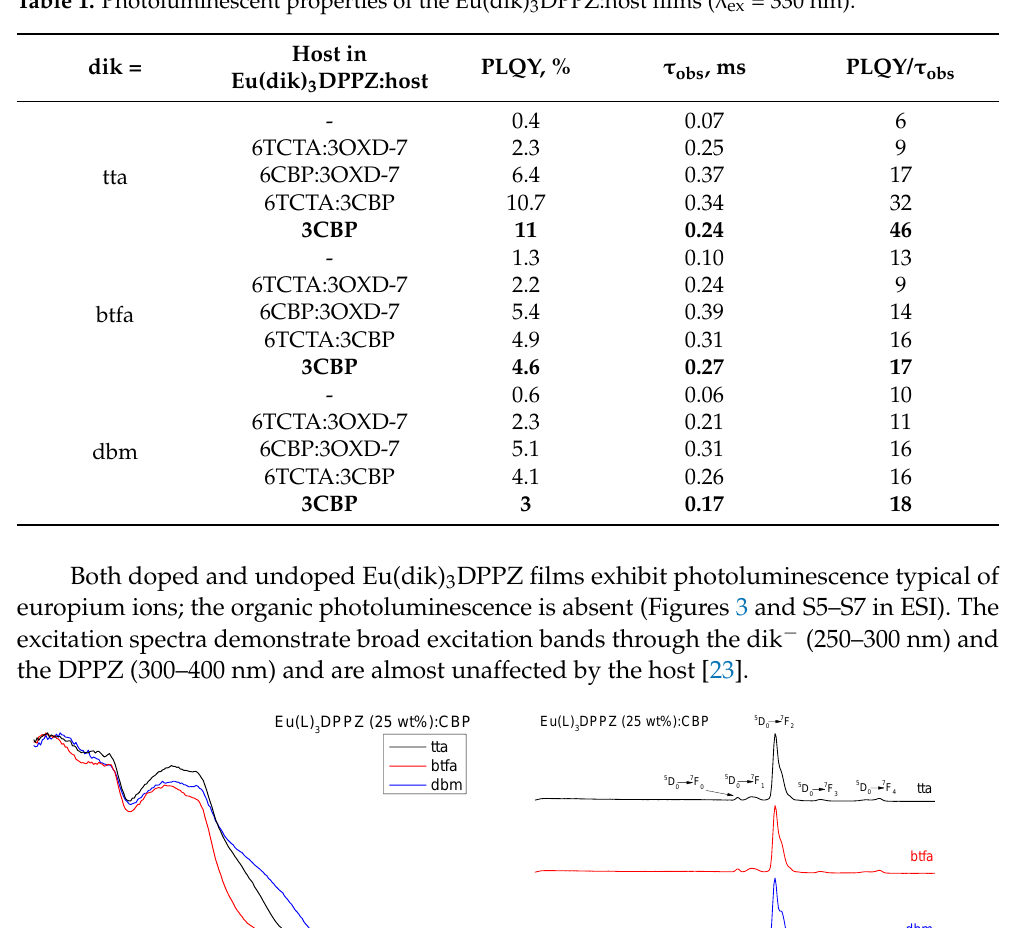
Table 1. Photoluminescent properties of the Eu(dik) 3 DPPZ:host films (  ex = 330 nm). Host in dik =